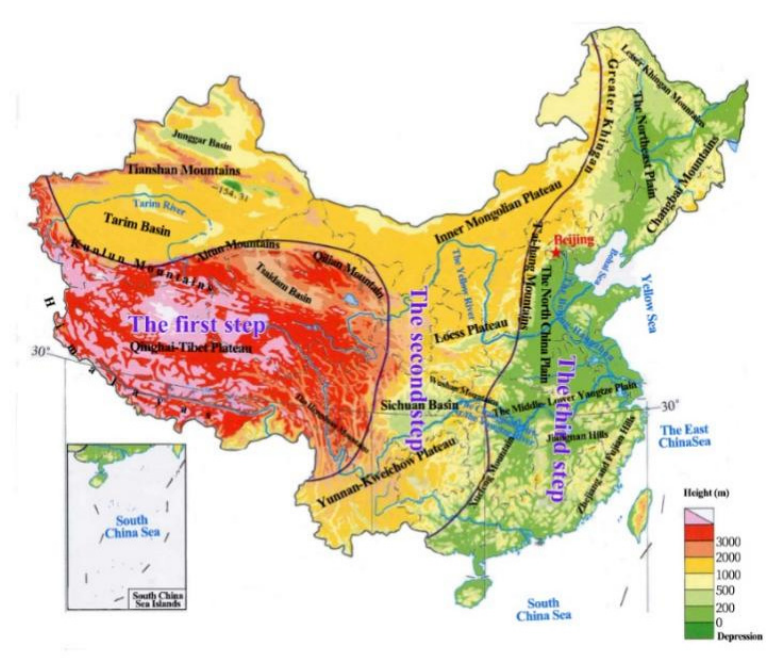
Figure 5. Three Tectono-Geomorphic Steps (modified from [104]).